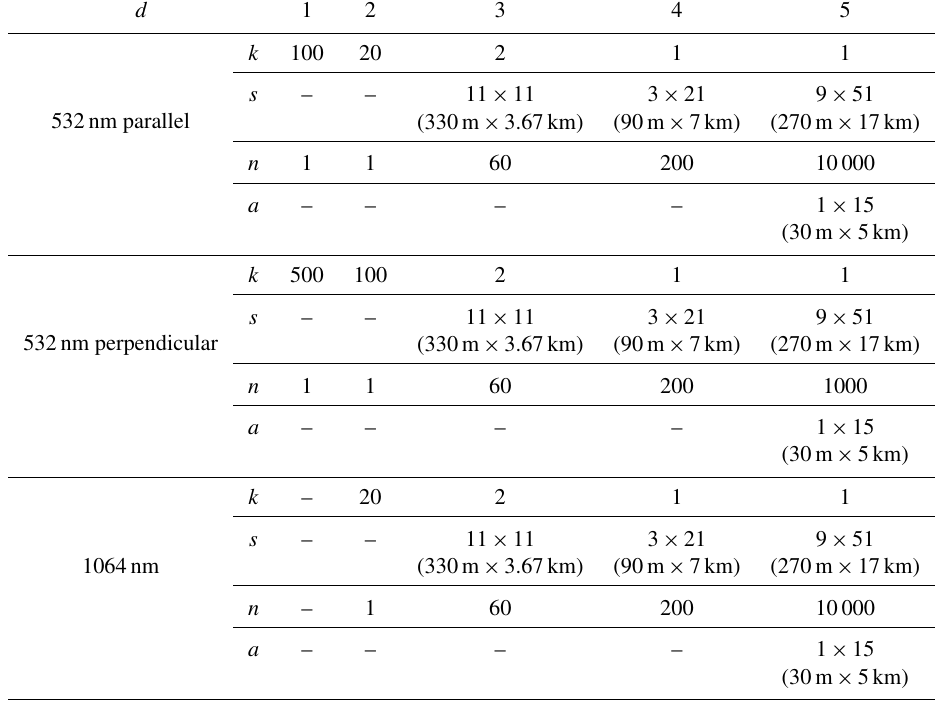
Table 1. Coefficient k in threshold detection, spatial coherence test window size s , minimum number of pixels in pattern n and averaging window size a used at each detection level d . Window sizes are given in vertical × horizontal pixel counts, with a single pixel resolution of 30m ×